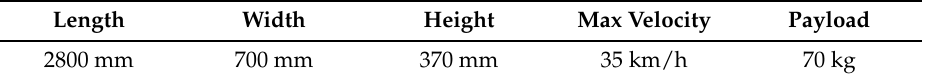
Table 1. Parameters of the USV in our experiment.